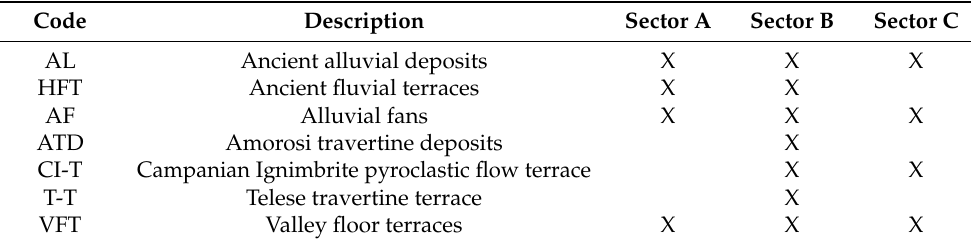
Table 2. Distribution of main landforms and deposits in the three sectors and associated codes.